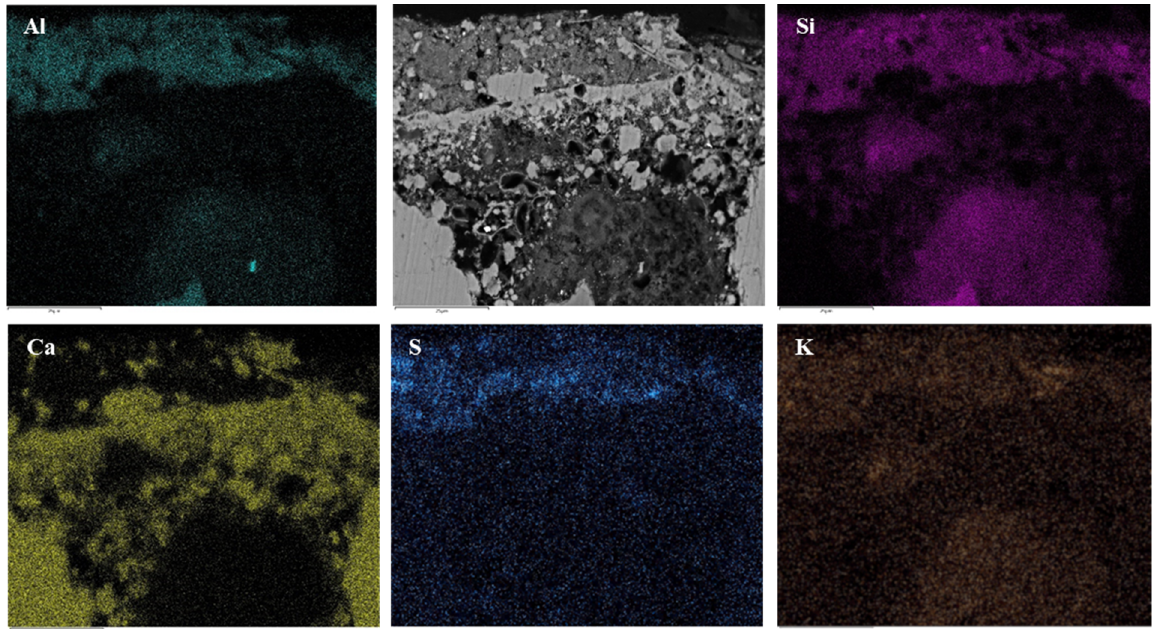
Figure 6. SEM-BSE photomicrographs and X-ray maps (Al, Si, K, S, Ca) of cross section of sample 1 of the tomba della Nike showing, from upper to lower, madder lake pigment, Ca-based layer and plaster.